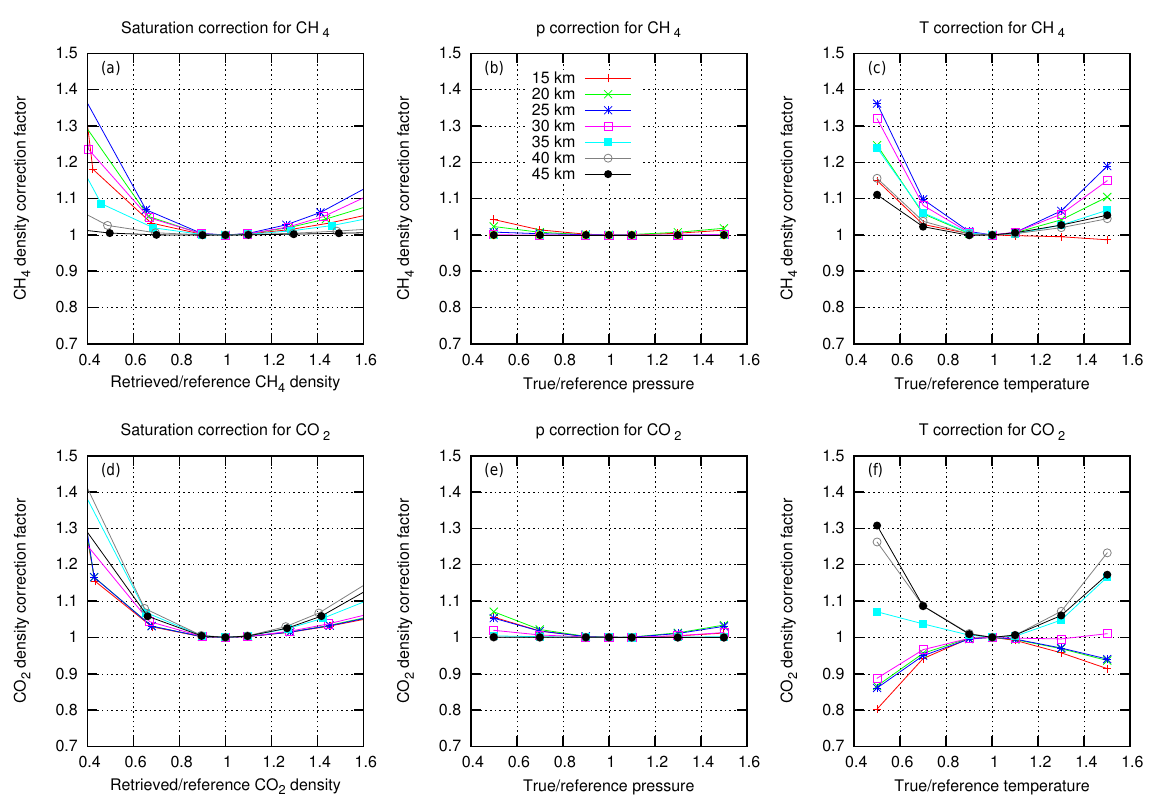
Figure 5. (a) Saturation correction factors for CH 4 . (b) Pressure correction factors for CH 4 . (c) Temperature correction factors for CH 4 . (d) Saturation correction factors for CO 2 . (e) Pressure correction factors for CO 2 . (f) Temperature correction factors for CO 2